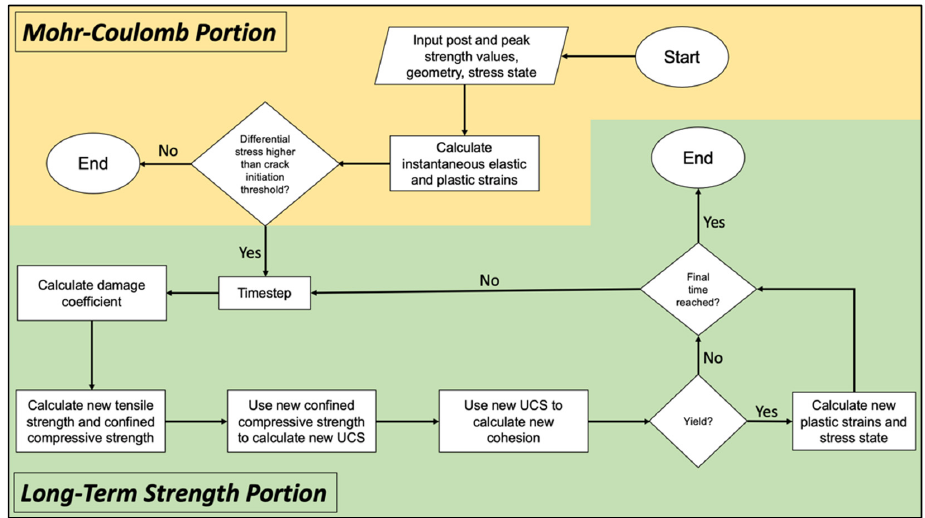
Figure 6. Workflow of strength-degradations portion for the long-term strength model for application into finite difference continuum models.